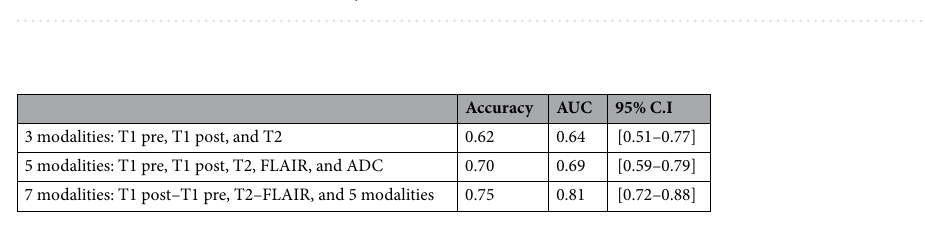
Table 1. Classification mean accuracy, AUC, and 95% C.I. for VGG16 models.